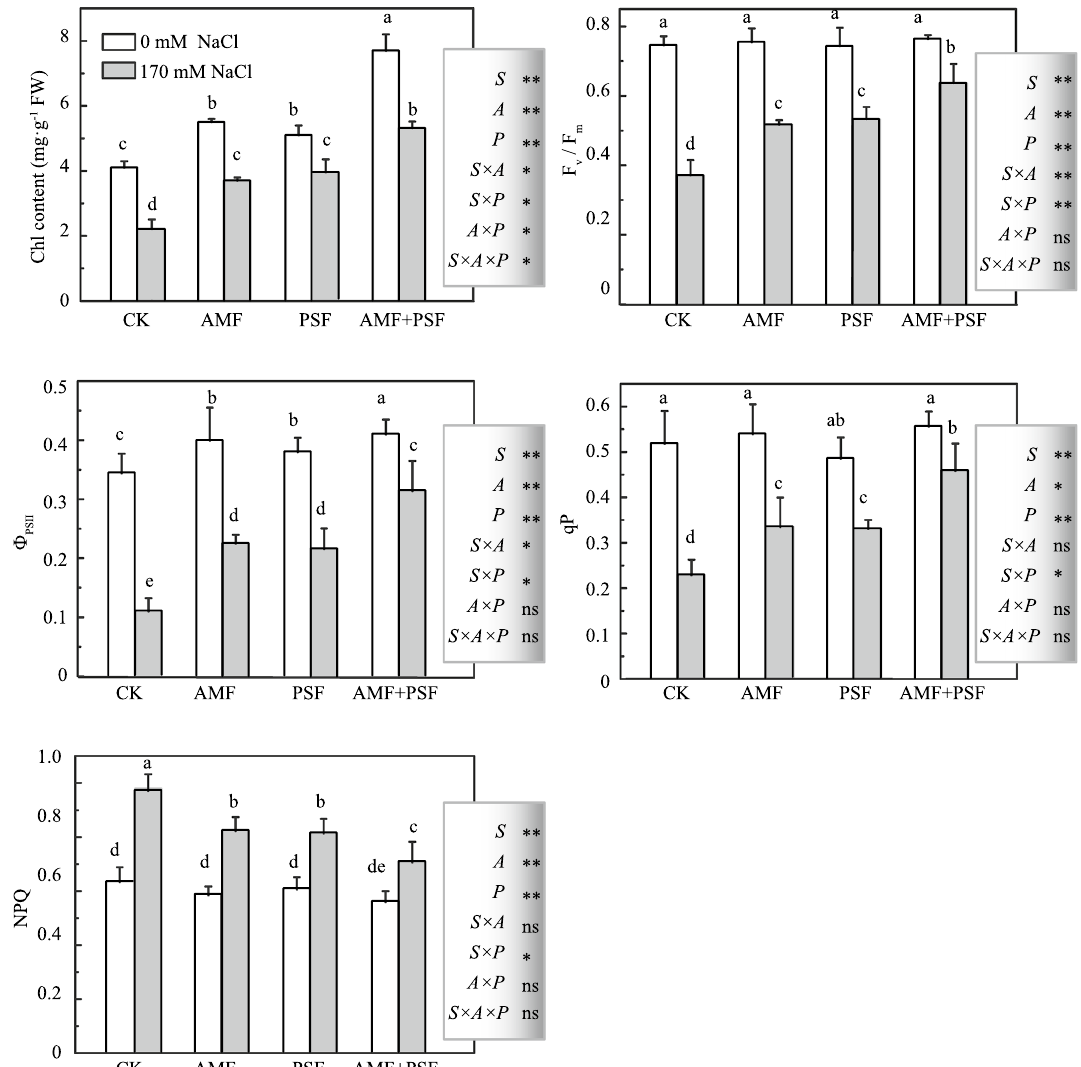
Figure 3. Effect of F. mosseae and/or A. spartima on the chlorophyll fluorescence parameters of beach plum under saline and non-saline conditions . The values of each parameter labeled by different letters indicate significant differences assessed by Duncan’s test after performing a three-way MANOVA ( p < 0.05). ns non- significant; *significant at p < 0.05; **significant at p <